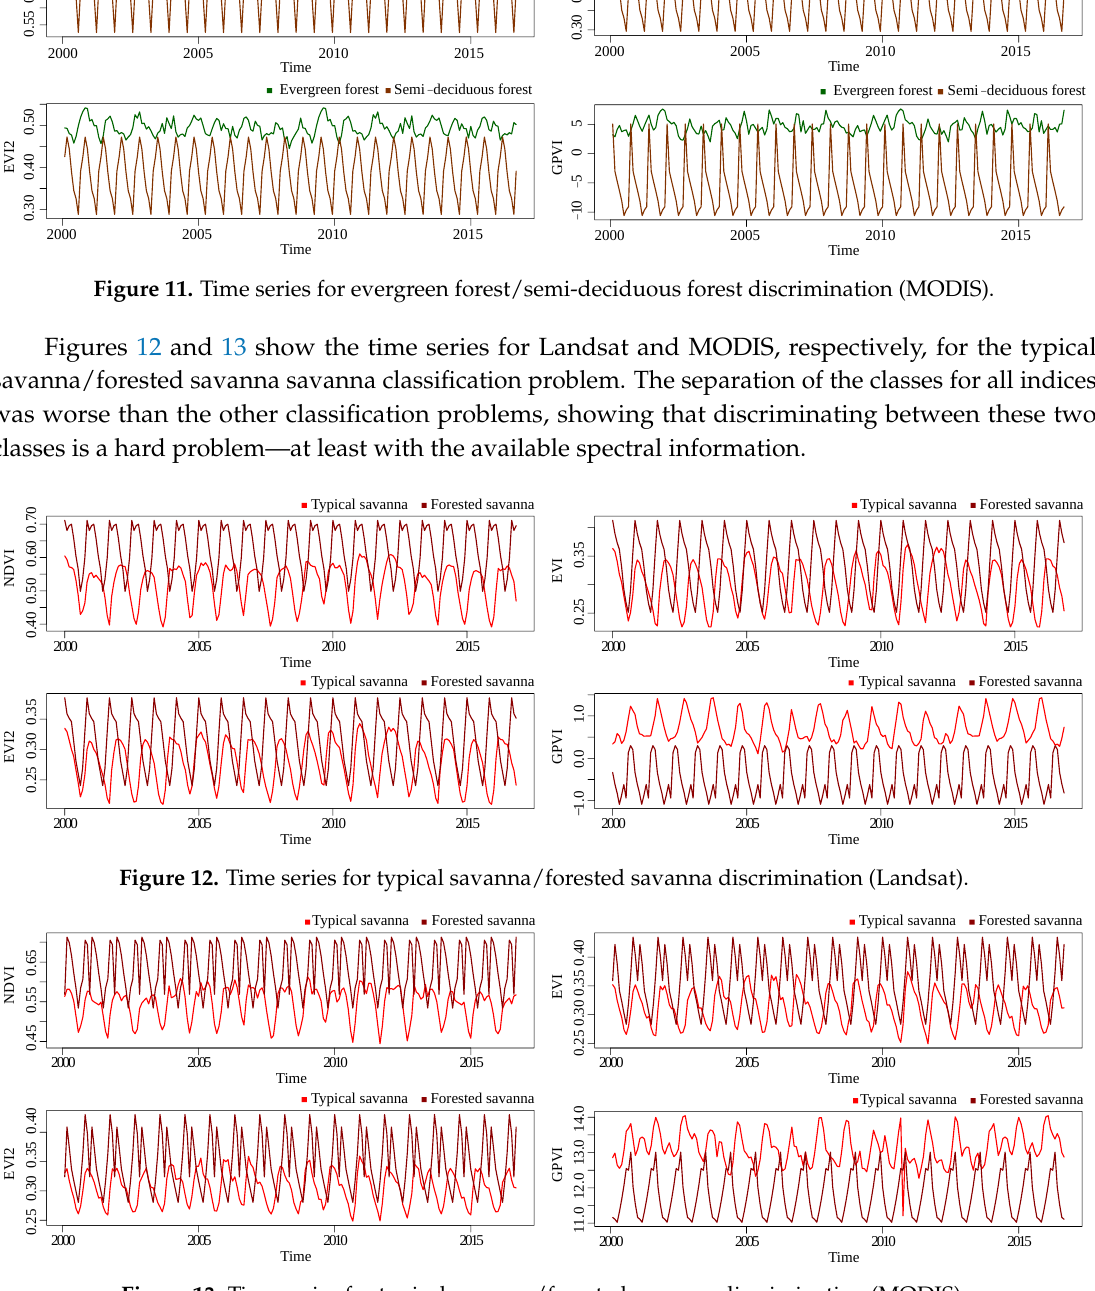
Figure 13. Time series for typical savanna/forested savanna discrimination